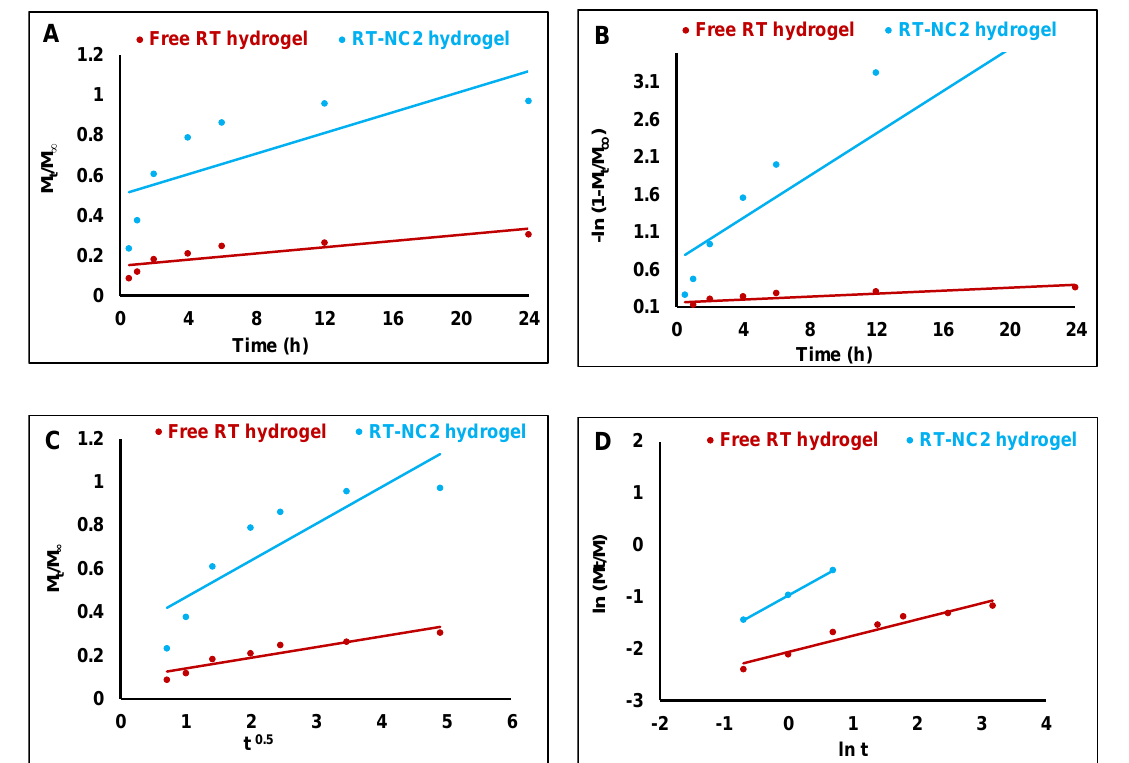
Figure 7. Plots of RT release data according to different kinetic models. ( A ) Zero order, ( B ) first order, ( C ) Higuchi diffusion model, ( D ) and Korsmeyer–Peppas equation. Table 6. Kinetic parameters of various models of RT release data from free RT and RT-NC2 hydro- gels.